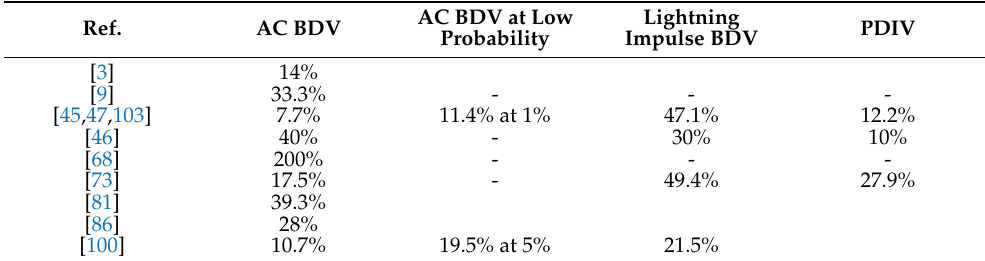
Table 19. Properties’ maximal variations showed by nanofluids vs. aged base oils in the analyzed